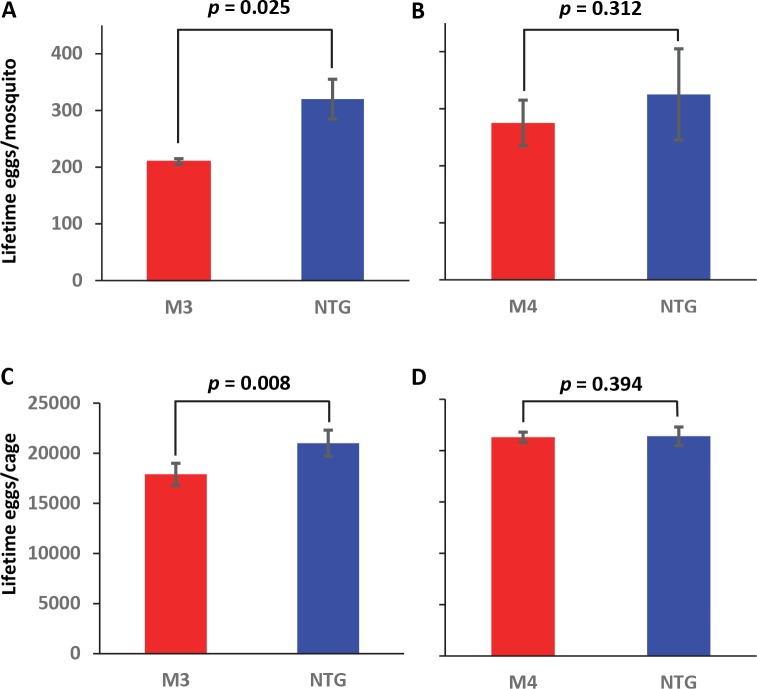
MKP4 overexpression in the midgut of A. stephensi reduced lifetime fecundity in M3 line transgenic mosquitoes relative to non-transgenic mosquitoes.Lifetime fecundity was assessed at the individual (A, B) and cage or population (C, D) levels. Bars represent the combined average total number of eggs per individual (A, B) or for the entire cage or population (C, D) through to the end of lifespan. The experiment was replicated four times with separate cohorts of mosquitoes and data were analyzed using Student’s t-test.